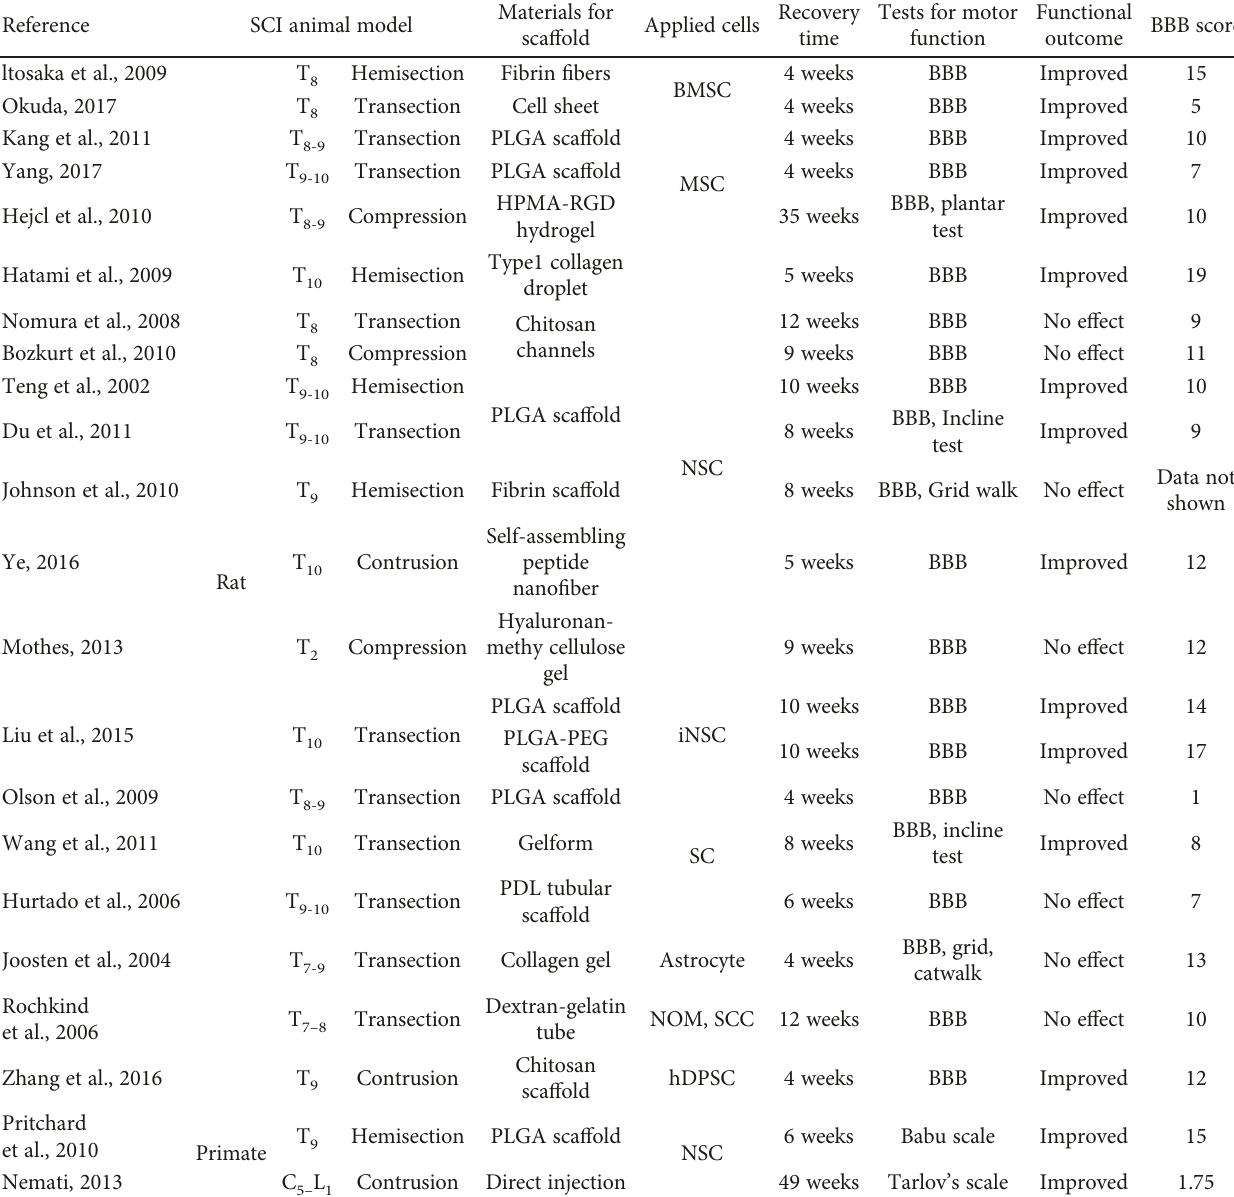
Table 1: Animal models of stem cell injury (SCI) and multifaceted approaches to cellular